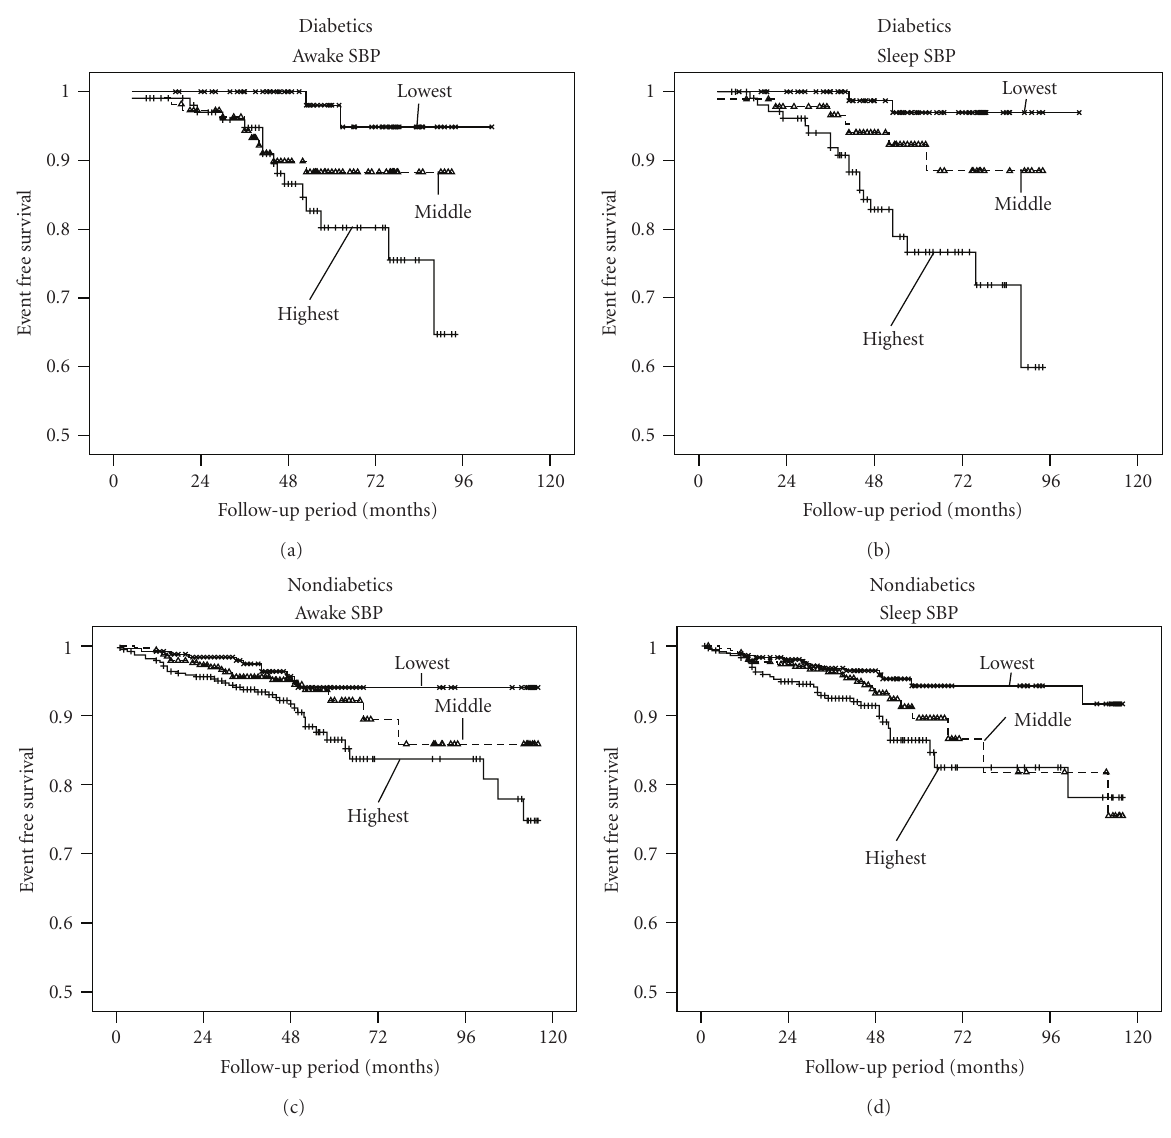
(c) Figure 3: Event-free survival Kaplan-Meier curves for three categories of awake and sleep SBP. The log-rank statistic between the highest- and lowest-awake SBP is 11.2 ( P = . 001) for the diabetes and 8.4 ( P = . 004) for the non-diabetes group, while that between the middle- and lowest-awake SBP is 4.5 ( P = . 03) for the diabetes and 1.0 ( P = . 32) for the non-diabetes group. The log-rank statistic between the highest- and middle-awake SBP is 1.8 ( P = . 19) for the diabetes and 4.0 ( P = . 046) for the non-diabetes group. The log-rank statistic between the highest- and lowest-sleep SBP is 16.3 ( P < . 001) for the diabetes and 11.3 ( P = . 001) for the non-diabetes group, and that between the middle- and lowest-sleep SBP is 3.3 ( P = . 07) for the diabetes and 3.8 ( P = . 05) for the non-diabetes group. The log-rank statistic between the highest- and lowest-sleep SBP is 6.4 ( P = . 01) for the diabetes and 1.9 ( P = . 17) for the non-diabetes group. SBP indicates systolic blood pressure (adopted from